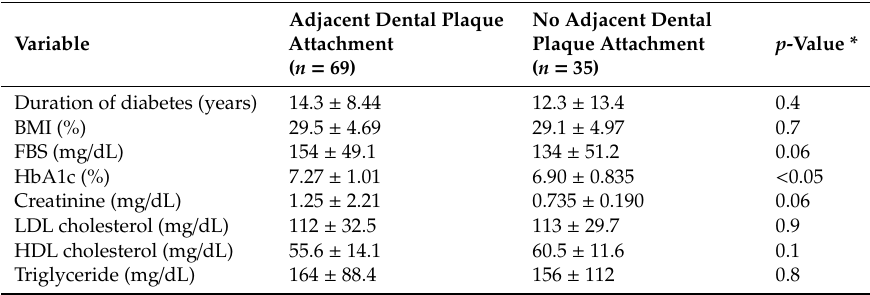
Table 2. Characteristics of the groups with and without adjacent dental plaque attachment.